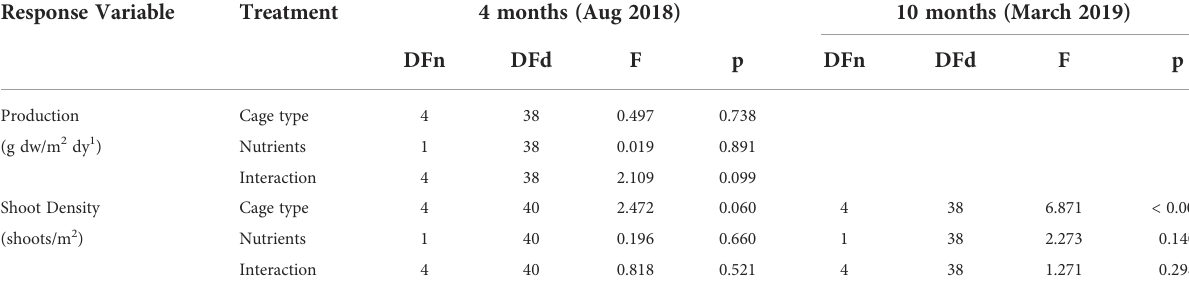
TABLE 1 2-way Analysis of Variance results on Thalassia testudinum response variables during a caging experiment testing Cage types and Nutrient enrichment as the Treatment variables. Response